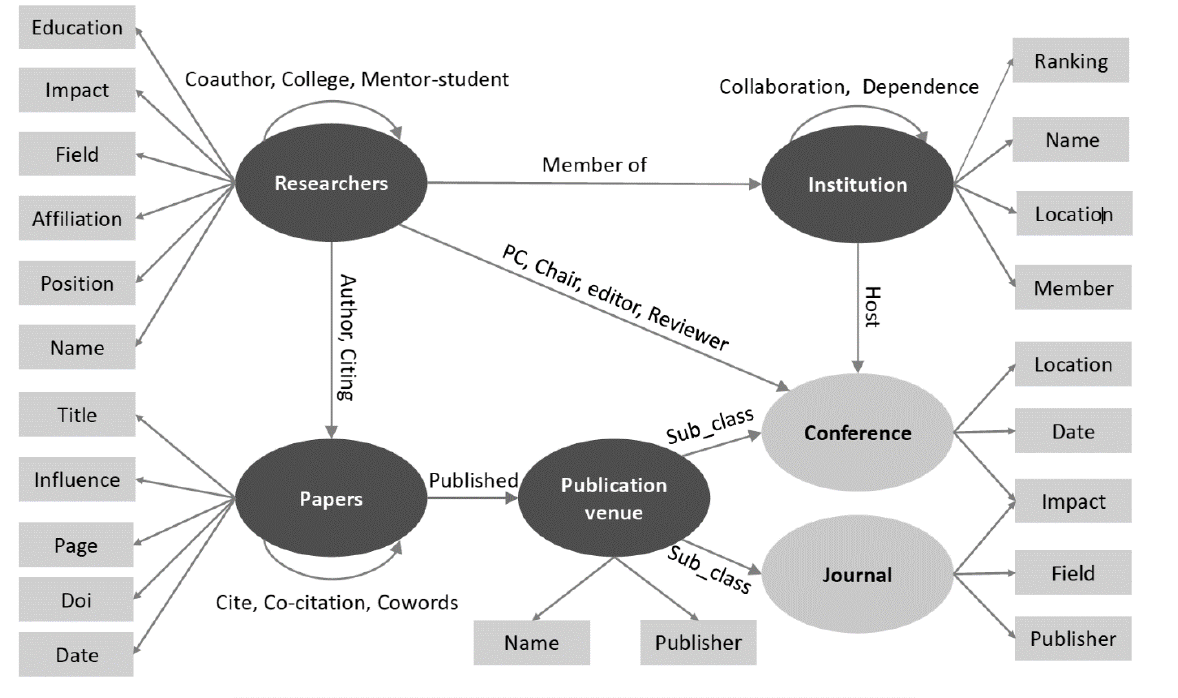
Figure 1. Major entities and their relationships in Big Scholarly Data